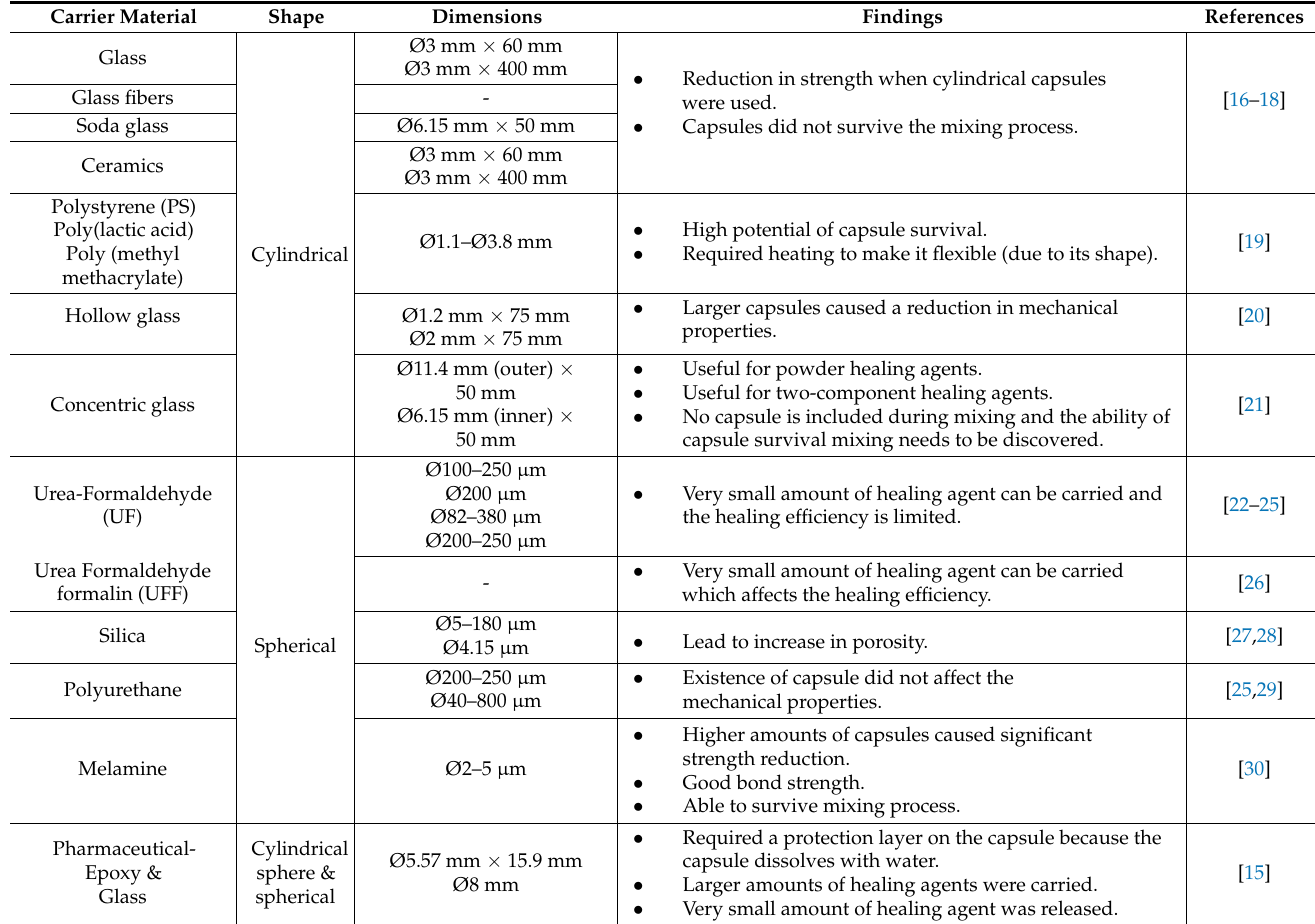
Table 1. Studies on encapsulation method in self-healing of cementitious